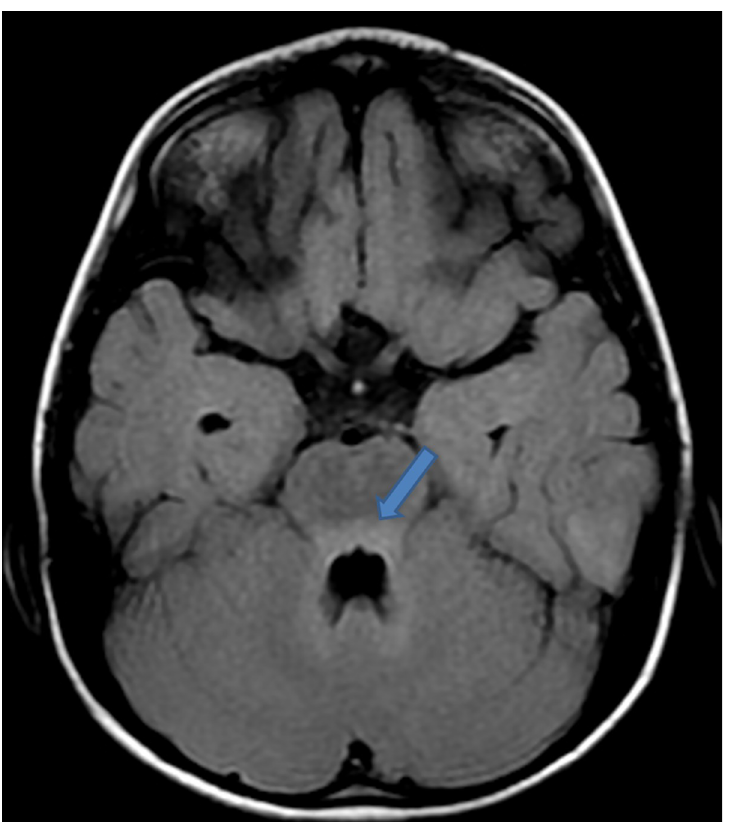
Fig 4. T2/FLAIR hyperintensities noted in posterior 1/3 of pons, pontomedullary junction, medulla oblongata, and posterior part of left temporal gyri.